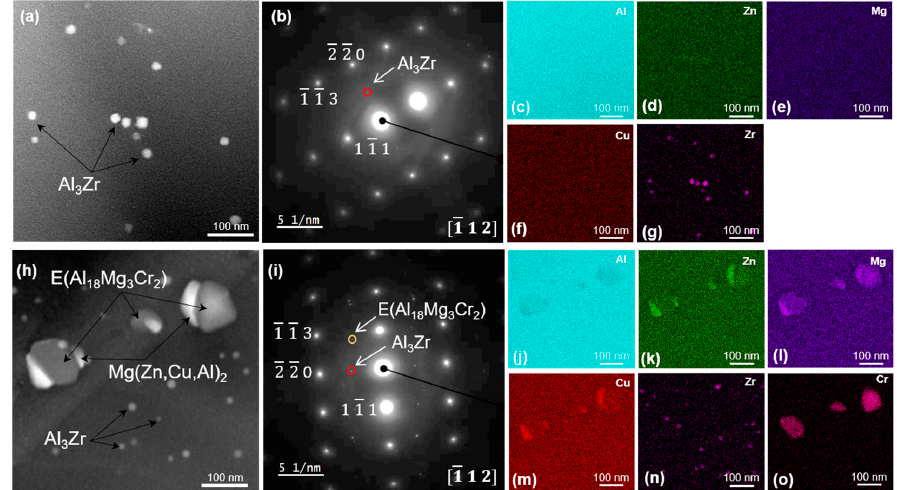
Figure 7. STEM dark-field images and SAED patterns of 7449 ( a , b ) and 7449+Cr ( h , i ). The corresponding EDX maps of STEM images in ( a ) and ( h ) for 7449 and 7449+Cr, respectively, are shown in ( c – g ) and 7449+Cr ( j – o ).